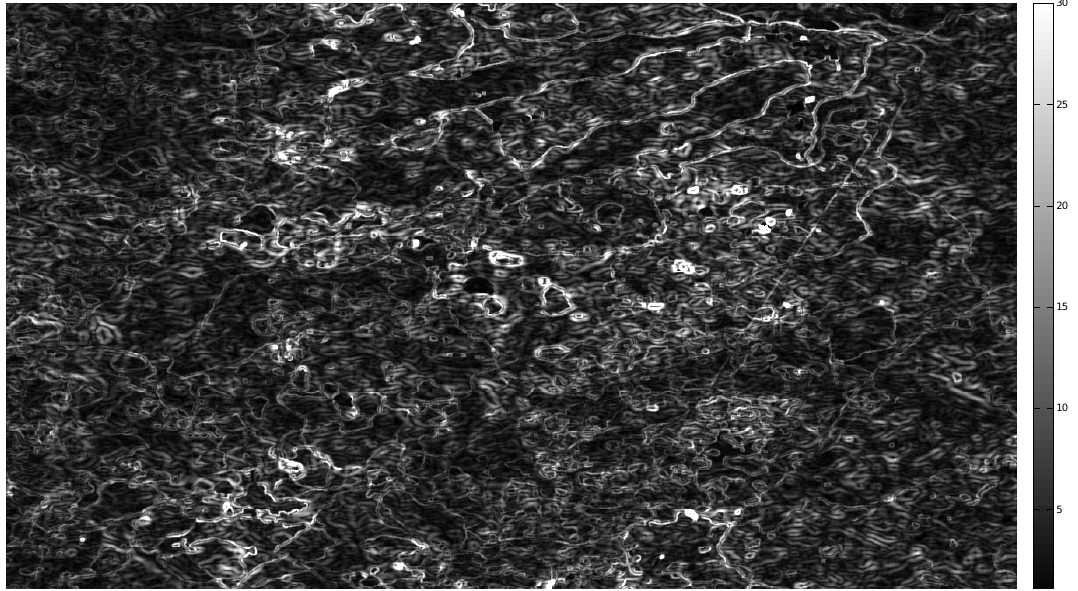
Figure 9. Local Range Variation (LRV) feature descriptor.